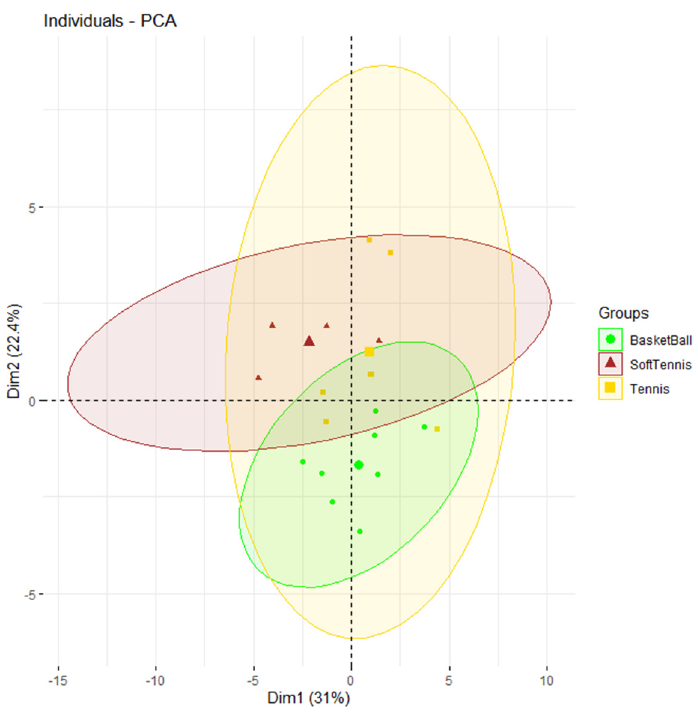
Figure 3. Confidence interval estimate for each group.